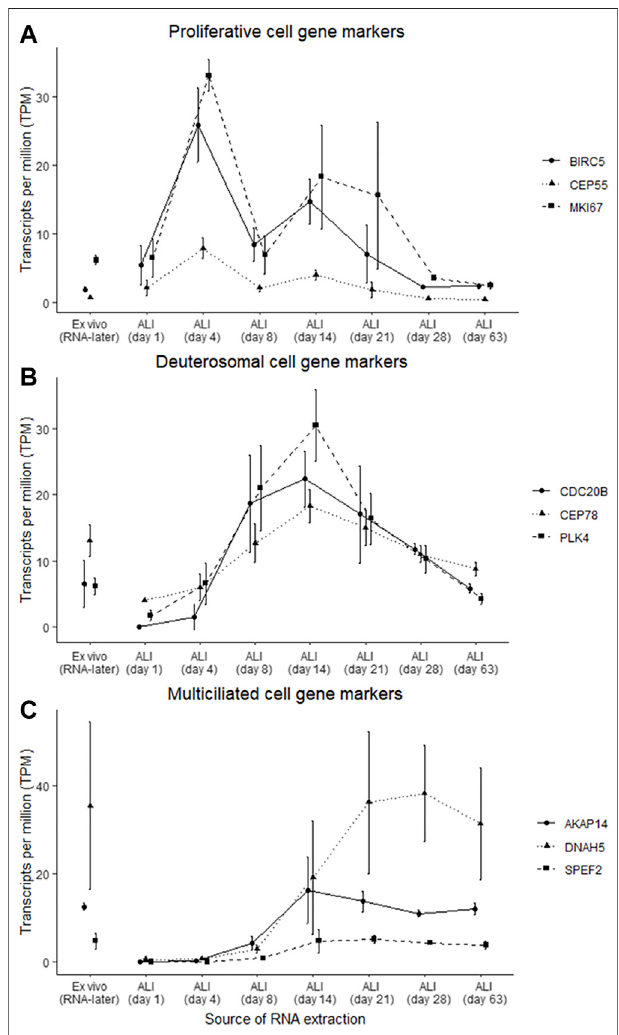
FIGURE 4 | Gene marker expression changes indicated speci fi c cell type changes at different ALI-culture time-points. Gene markers, which were previously identi fi ed (Ruiz García et al., 2019), belonging to proliferative, deuterosomal and multiciliated cells were assessed in the ex vivo nasal brushing cells stored in RNA-later ® samples and the in vitro nasal epithelial cells cultured at ALI. (A) Peak abundance of the gene markers (BIRC5, CEP55, and MKI67) associated with proliferative cells occurs at day 4 of the ALI-culture. (B) Abundance of the gene markers (CDC20B, CEP78, and PLK4) associated with deuterosomal cells starts at ALI day 4 and peaks around day 14, while the gene marker (AKAP14, DNAH5, and SPEF2) transcripts of multiciliated cells appear from ALI day 8 onwards and peaking around day 14 and day 21. Proliferative and deuterosomal gene marker transcripts are more abundant in the ALI-cultures compared to the RNA- later ® samples, while the abundance of multiciliated gene marker transcripts between the ALI-cultures and the RNA-later ® samples are at similar levels around ALI day 14 and day 21 (C) . Three healthy donors were used for each